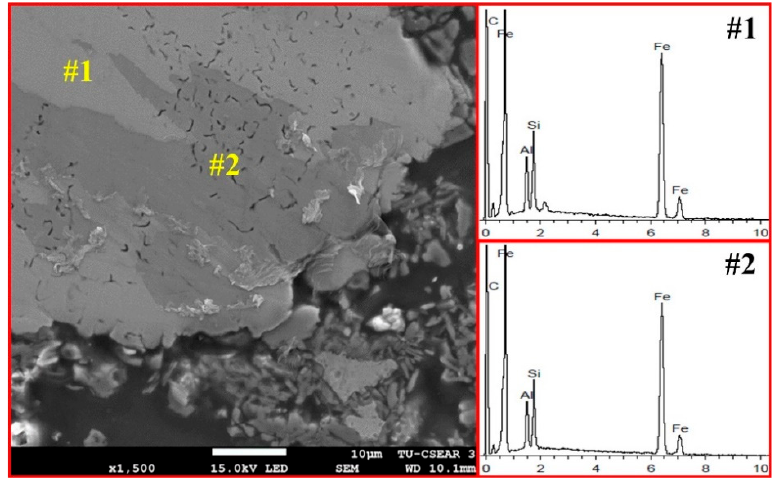
Figure 7. SEM micrograph and EDS spectra of the cross-sectioned pellet (C/O = 1) after heating at 1550 °C for 3 h.